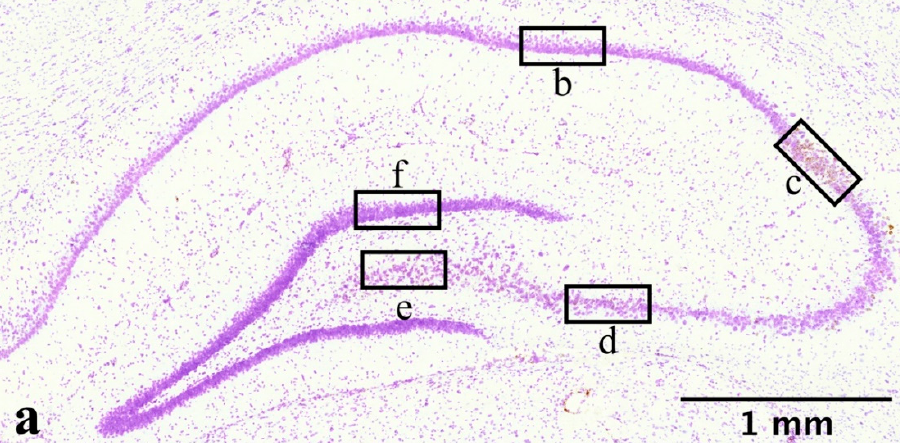
Figure 8. Overview of hippocampal anatomy and locations of image acquisition. Stitched image ( a ) of ipsilateral hippocampus of female rat subjected to penetrating traumatic brain injury and a survival time of 3 days. Acquired at 20 × magnification using a Nikon Eclipse Ni-E microscope. Acquired at Bregma: − 3.84 mm. RNAscope in-situ hybridization marked CYP1B1 mRNA in brown. Black boxes ( b – f ) show location and scope of image captured as well as CYP1B1 mRNA markings. Box ( b ) depicts CA1, ( c ) CA2, ( d ) CA3, ( e ) CA4 and ( f ) DG. Abbreviations: CA: Cornu Ammonis, CYP1B1: Cytochrome P450 1B1, DG: Dentate